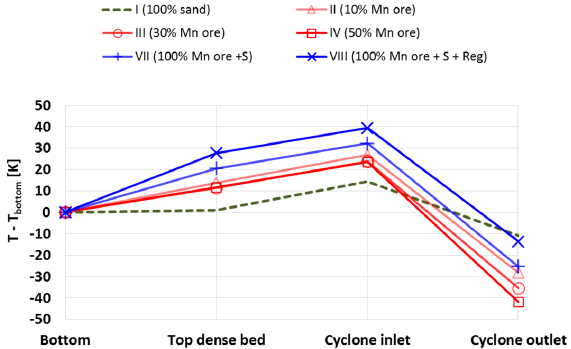
Figure 3. Temperature profile over the boiler when operated on lower air-to-fuel-ratio ( ≈ 1.07). T bottom was in the range 866–877 °C and have been used as reference.